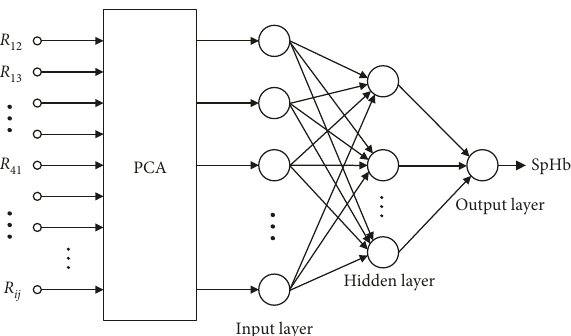
Figure 3: The general structure of BP-ANN